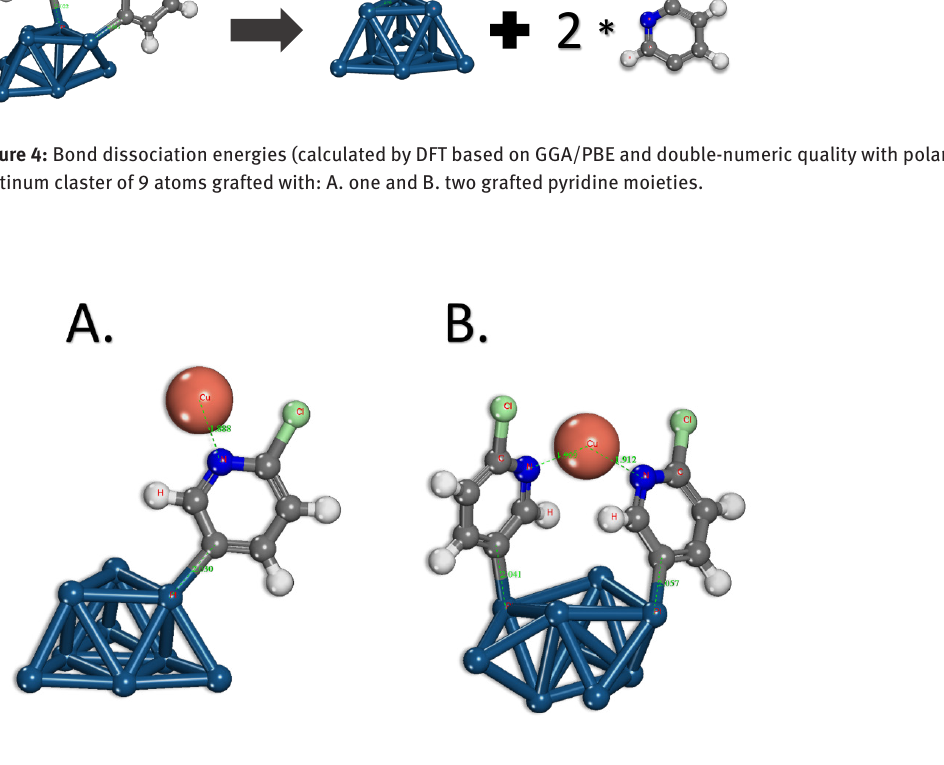
Figure 5 : The optimized structures for the interaction of copper (II) ions with: A. one (mono-dentate) and B. two (bi-dentate) two attached chloropyridine